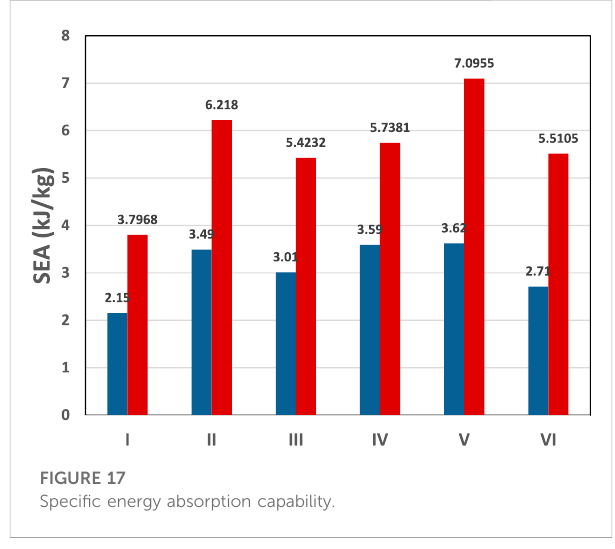
FIGURE 16 Energy absorption capability.